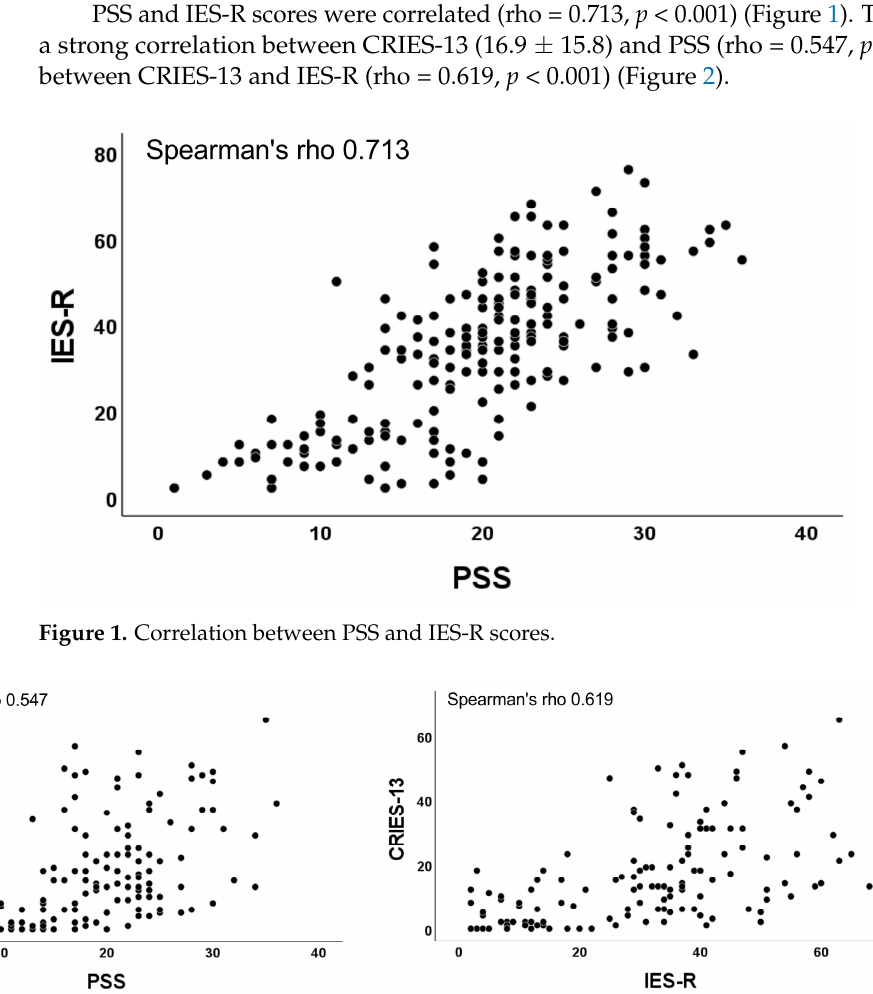
Figure 2. Correlation between CRIES-13 and PSS, and CRIES-13 and IES-R scores.